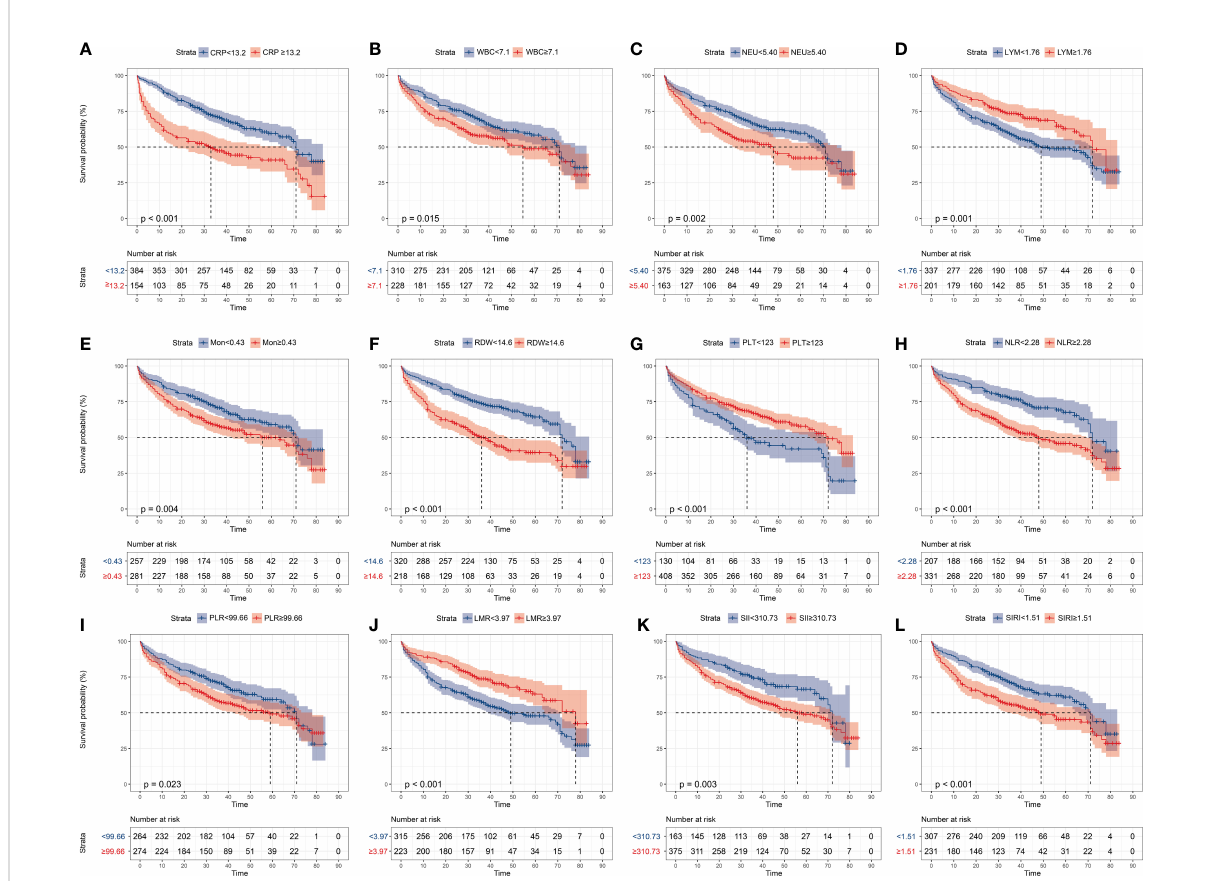
FIGURE 2 Kaplan-Meier analysis of the in fl ammatory markers in all-cause mortality in patients with AHF, grouped by ROC optimal cut-off values. (A) CRP, C-reactive protein; (B) WBC, white blood cell; (C) NEU, neutrophils; (D) LYM, lymphocyte; (E) Mon, monocyte; (F) : RDW, red cell distribution width; (G) PLT, platelet; (H) NLR, neutrophil-to-lymphocyte ratio; (I) PLR, platelet-to-lymphocyte ratio; (J) LMR, lymphocyte-to-monocyte ratio monocyte; (K) SII, systemic immune-in fl ammation index; (L) SIRI, systemic in fl ammatory response